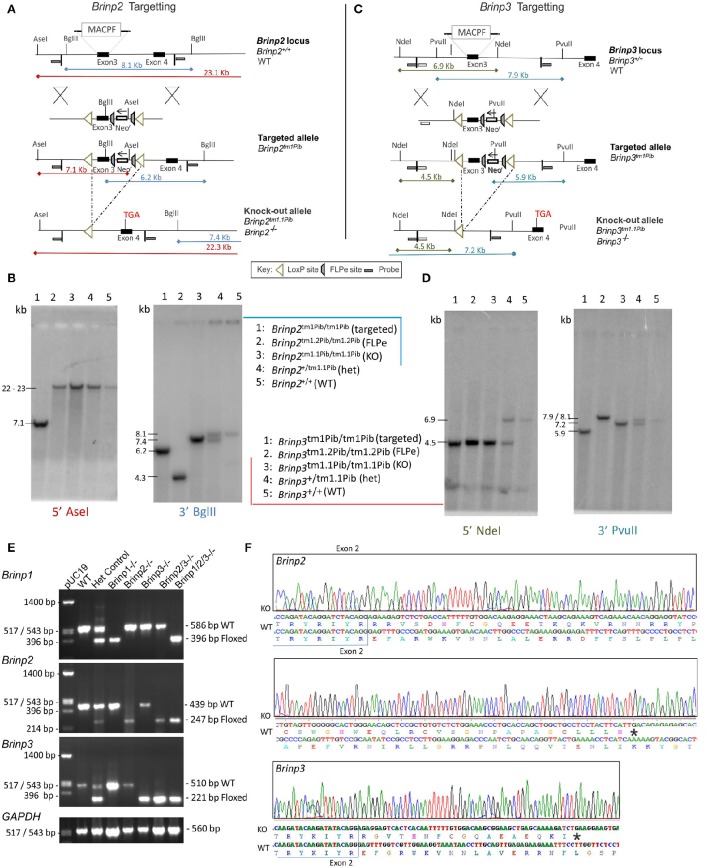
Brinp2 and Brinp3 Targeting. (A) The Brinp2 targeting vector was designed with a Neomycin resistance (Neo-r) cassette after exon 3, and FRT sites placed before and after the Neo-r cassette. The 192 bp 3rd exon of Brinp2 contains the start of the Membrane Attack Complex/Perforin (MACPF) domain. LoxP sites flank exon 3 and the Neo-r cassette. When crossed with a global Cre-deleter mouse line, the recombination of LoxP sites resulted in the deletion of exon 3 and the Neo-r cassette. (B)
Brinp2 Southern Blot: splenic genomic DNA was cleaved with PstI and BglII and hybridized to 500 bp genomic DNA probes from the 5′ region (Asel) and 3′ region (Bgl II) of the targeting construct. In wild-type DNA, species of 23.1 kb (Asel) and 8.1 kb (Bgl II) were detected. The 8.1 kb (Bgl II) species was not present in DNA from Brinp2−/− mutants, replaced with shorter species 7.4 kb (BglII). (C) The Brinp3 targeting vector was designed with a Neo-r cassette after exon 3, and FRT sites positioned before and after the Neo-r Cassette. The 289 bp 3rd exon of Brinp3 contains the start of the MACPF domain. LoxP sites flank exon 3 and the Neo-r cassette. When crossed with a global Cre-deleter mouse line, the recombination of LoxP sites resulted in the deletion of exon 3 and the Neo-r cassette. (D)
Brinp3 Southern Blot: splenic genomic DNA was cleaved with PstI and BglII and hybridized to 500 bp genomic DNA probes from the 5′ region (Ndel) and 3′ region (PvuII) of the targeting construct. In wild-type DNA, species of 6.9 kb (Ndel) and 7.9 kb (PvuII) were detected. These products were not present in DNA from Brinp3−/− mutants, replaced with shorter species of 4.5 kb (Ndel) and 7.2 kb (PvuII). (E) Validation of knock-out line using cDNA derived from brain tissue mRNA from WT, heterozygous and Brinp2−/−
Brinp3−/−
Brinp2/3−/−
Brinp1/2/3−/− mice. For each genotype, PCR product sizes correspond to the removal of exon3 in the knock-out allele. (F) Sequencing of the Brinp2−/− and Brinp3−/− allele RT-PCR products showed the expected absence of exon 3, and that splicing fuses exons 2 and 4, resulting in a frame shift that introduces a stop codon after 50 (Brinp2−/−) and 18 (Brinp3−/−) residues. Sequencing results for Brinp1−/− allele can be found in previously published work (Berkowicz et al., 2016).